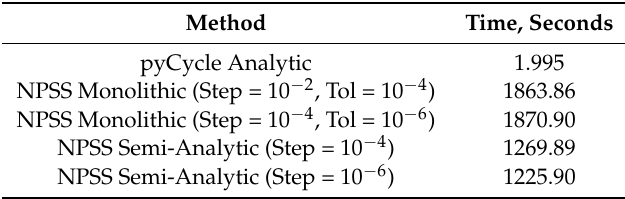
Figure 10. TSFC total derivative error for semi-analytic and monolithic approaches. Table 5. Total derivative calculation